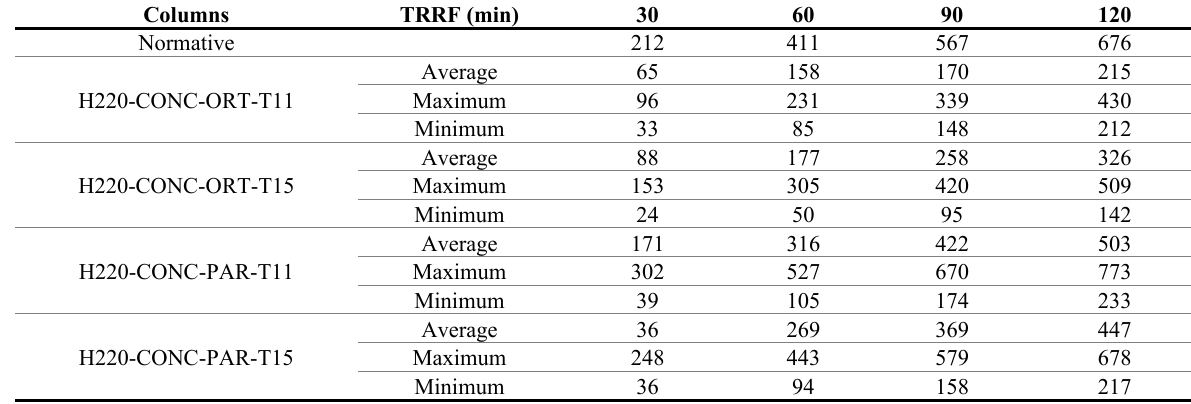
Table 10. Comparison of the temperatures obtained in the numerical model and the theoretical values for longitudinal reinforcement of the columns inserted into